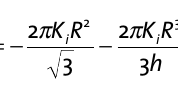
Figure 5: Kaolin clay compression test results (c = 0.4 mm/s, Á : rough plates, · : rectified